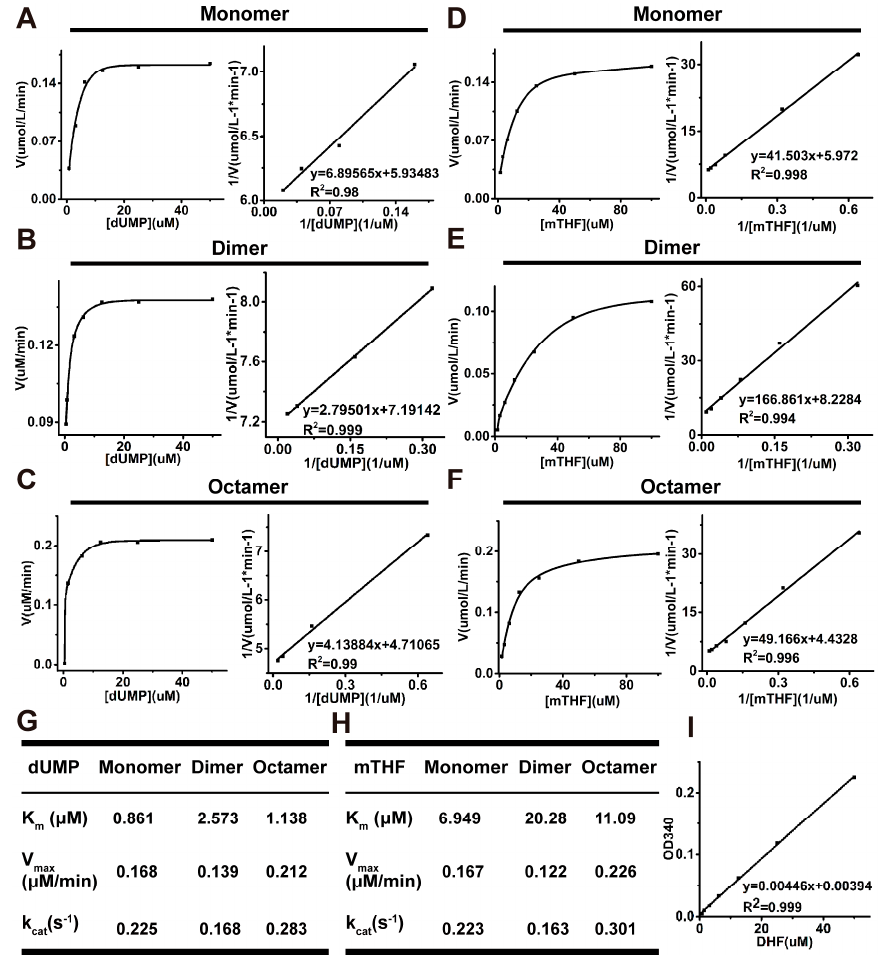
Figure 4. The reaction process curves and steady-state parameters for different oligomeric forms of TYMS. ( A ) Reaction process curves of dUMP for TYMS monomer, the left panel showing the substrate saturation curve, and the right panel showing the Lineweaver–Burk double-reciprocal plot; ( B ) reaction process curves of dUMP for TYMS dimer; ( C ) reaction process curves of dUMP for TYMS octamer; ( D ) reaction process curves of mTHF for TYMS monomer; ( E ) reaction process curves of mTHF for TYMS dimer; ( F ) reaction process curves of mTHF for TYMS octamer; ( G ) steady-state parameters of dUMP for different oligomeric forms; ( H ) steady-state parameters of mTHF for different oligomeric forms; ( I ) standard curve for ultraviolet absorption value at OD 340 of DHF.